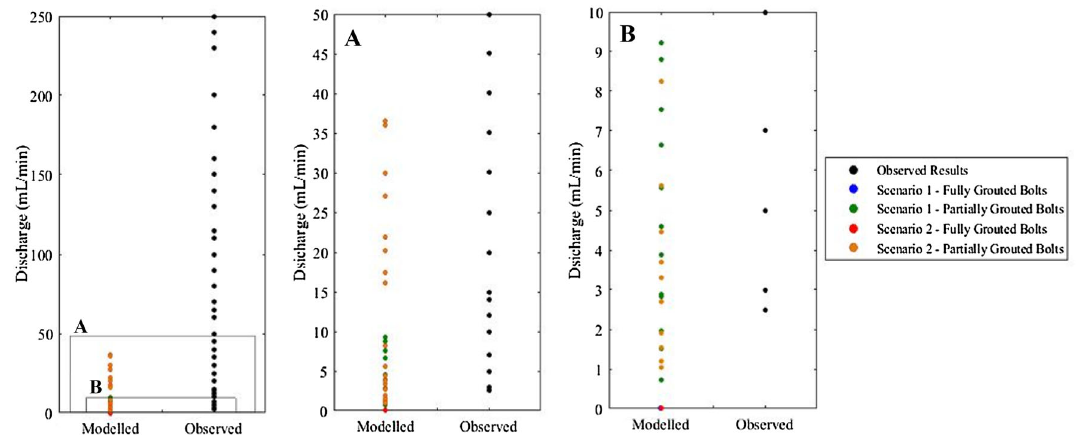
Fig. 3 Modelled versus observed groundwater discharge flow. Modelled partial grouted bolts for both Scenario 1 and 2 (base case hydraulic conductivity values) agree best with observed results